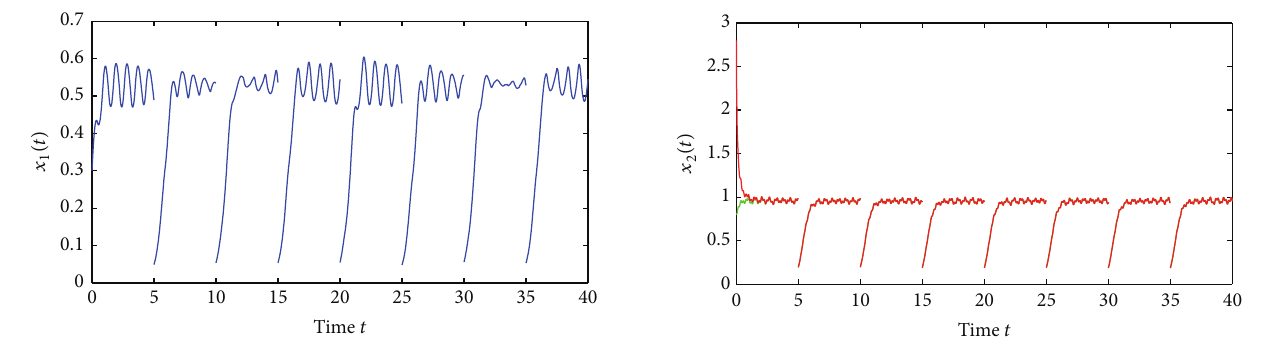
Figure 5: Stability of state variable 𝑥 2 of Example 1.